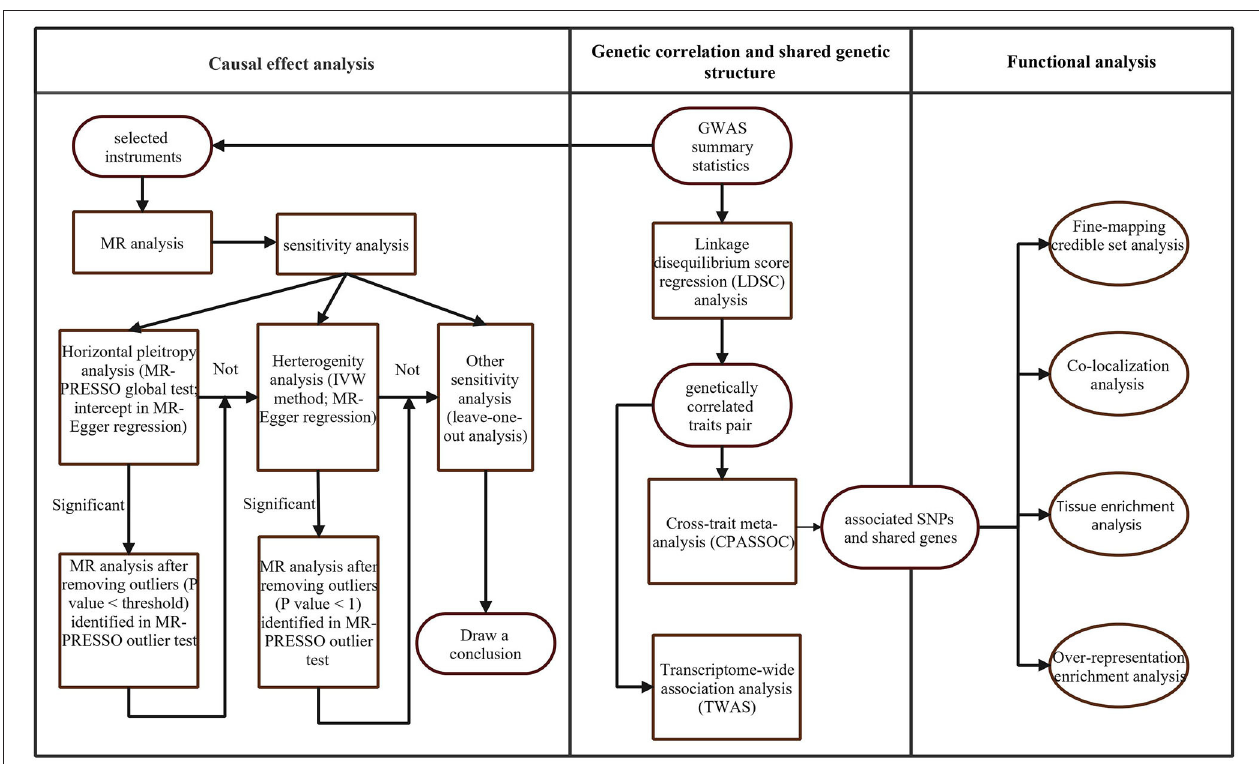
FIGURE 1 | Overall study